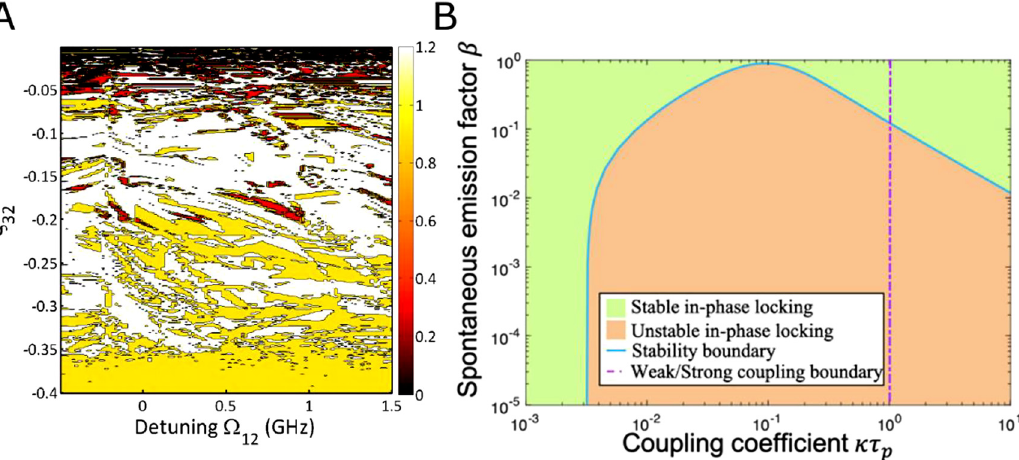
Figure 14: Stability maps. (A)Calculatedbifurcationdiagramofthreeoptoelectronicallycoupledfreerunningsemiconductorlasersasafunctionofdetuning Ω 12 andthe couplingcoef fi cient ξ 32 .Varyingsystemdynamicsareobservedsuchaschaos(magnitudeof0inthecolorbarwithblackcolor),winner-takes- all (WTA) competition (magnitude of 0.5 with red color), winner-shares-all (WSA) competition (magnitude of 1 with yellow color), and winnerless competition (magnitude of 1.2 with white color). (B) Stability regions for two laterally coupled metallo-dielectric nanolasers as a function of coupling coef fi cient κ and spontaneous emission factor β . The dash-dotted purple line demarcates the weak coupling ( κτ p < 1) and strong coupling ( κτ p > 1)